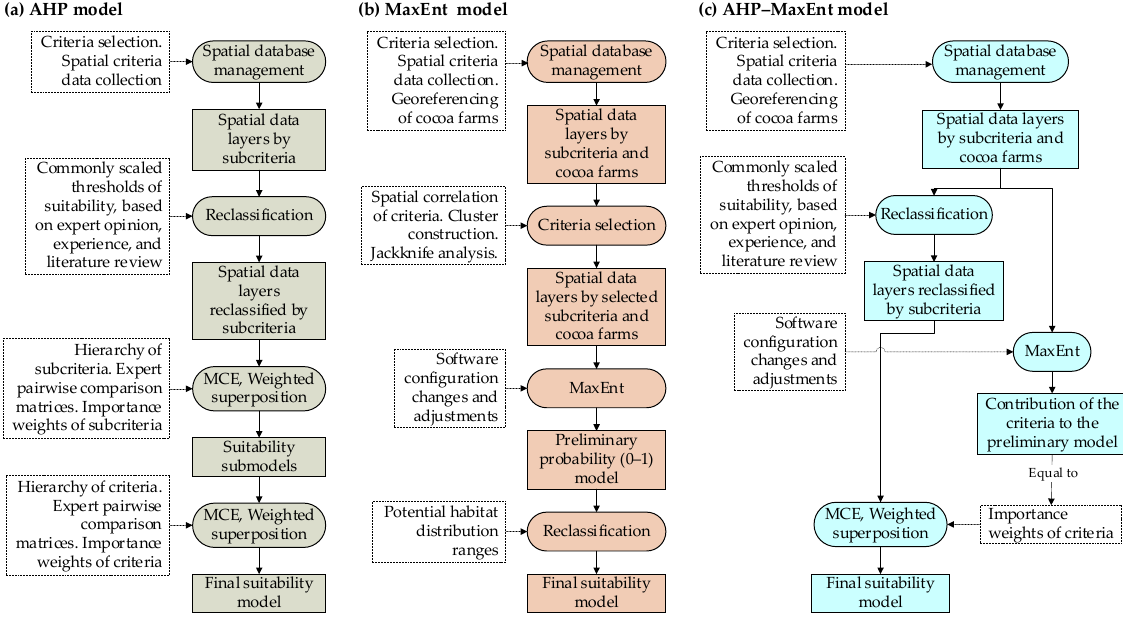
Figure 2. Flowchart of the methodology that includes the comparison of the inputs required by the user/developer for the AHP, MaxEnt and AHP–MaxEnt models.